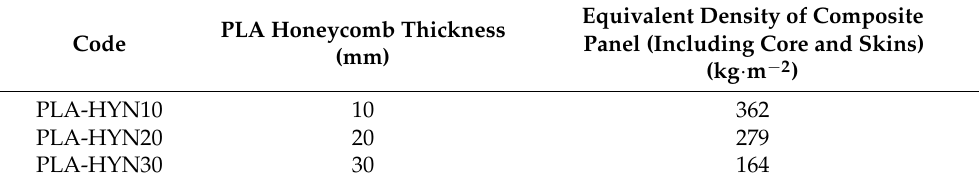
Table 1. Equivalent density of the composite sandwiches with PLA honeycomb cores with different